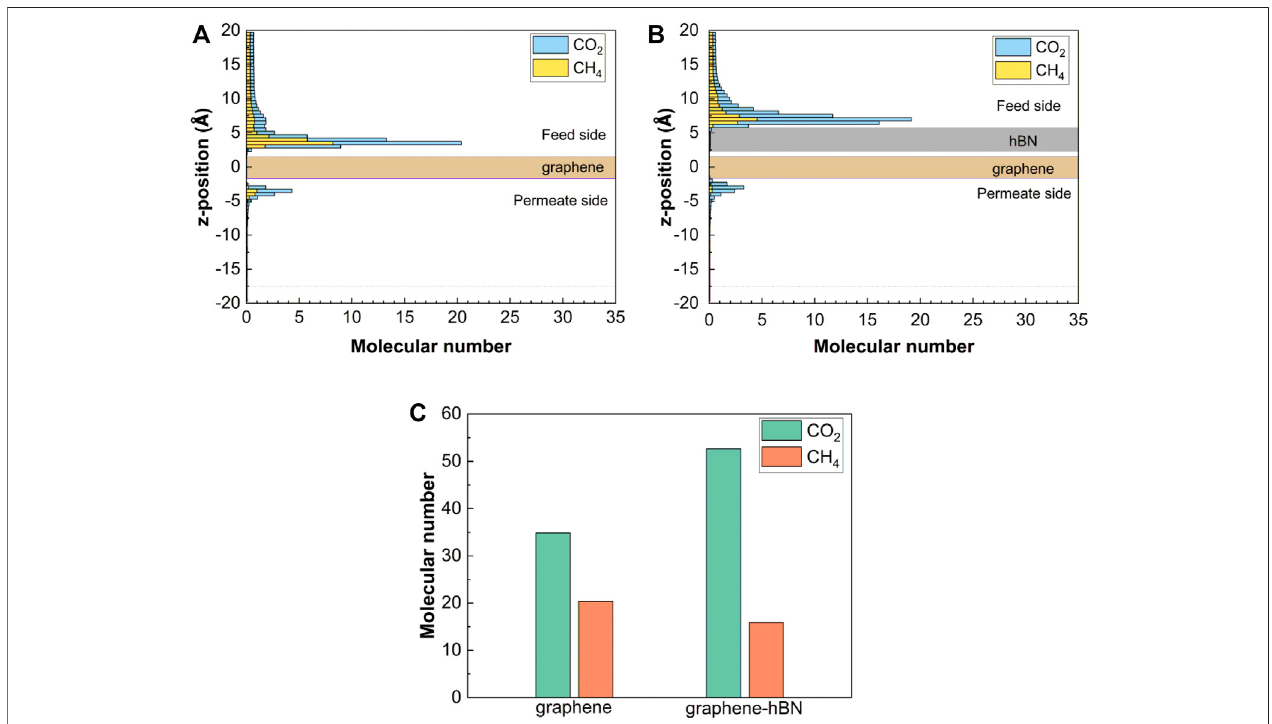
FIGURE3| Molecularadsorptioncharacteristicsonthetwosidesofsurface. (A) Numberdensitydistributionsofthemoleculesalongtheperpendiculardirectionon the graphene surface; (B) number density distributions of the molecules along the perpendicular direction on the graphene-hBN surface; (C) number of adsorbed molecules on the feed-side